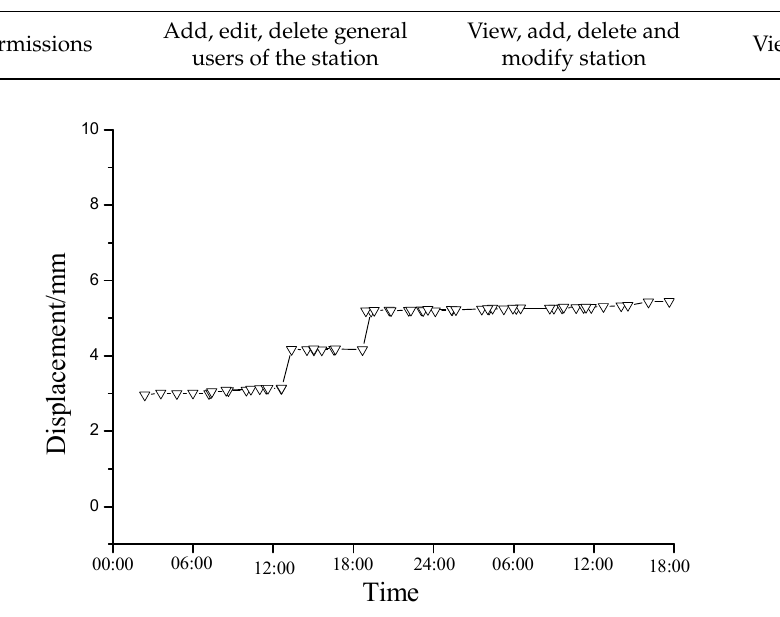
Figure 7. 5S-based data transmission flow chart.